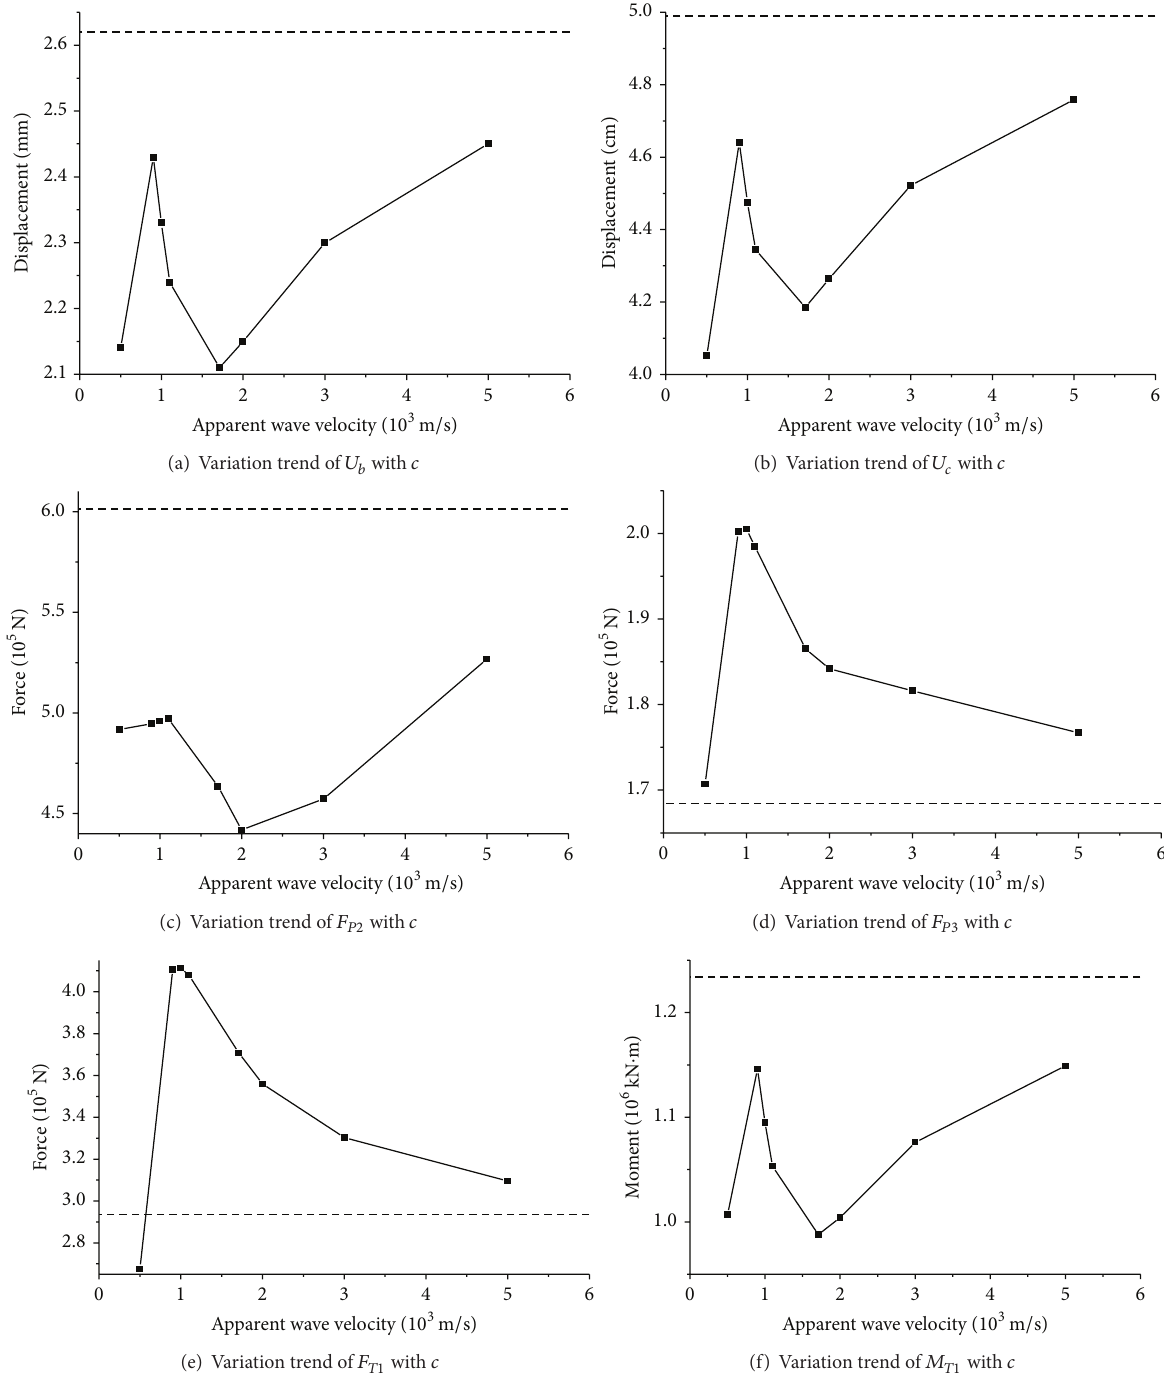
(f) Variation trend of 𝑀 𝑇1 with 𝑐